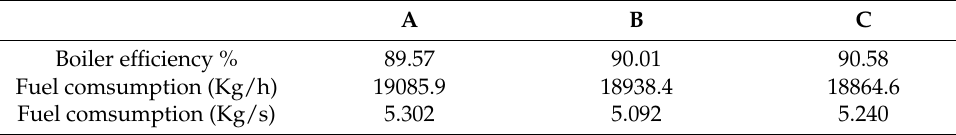
Table 2. Technical analysis comparing three arrangement alternatives.